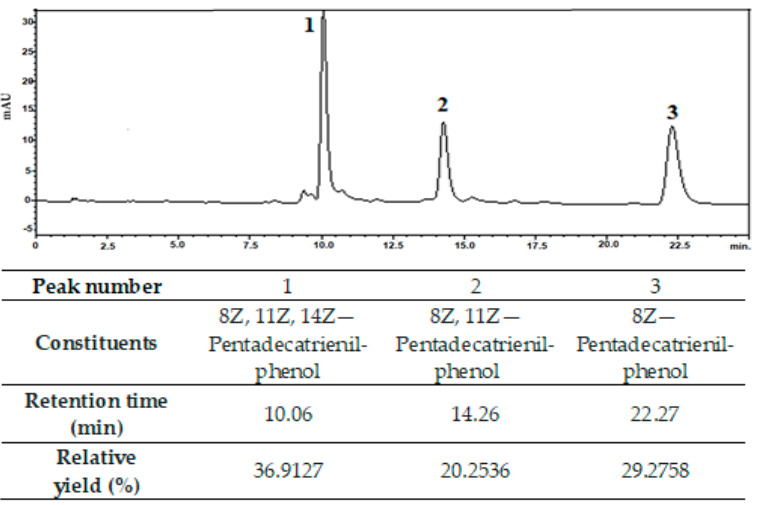
Figure 1. Representative high-performance liquid chromatography profile of cardanol. Column: Hy- persil GOLD ® 25 cm, run time: 25 min, flow rate: 1.80 L/min, mobile phase: 80:20 acetonitrile:acetic acid